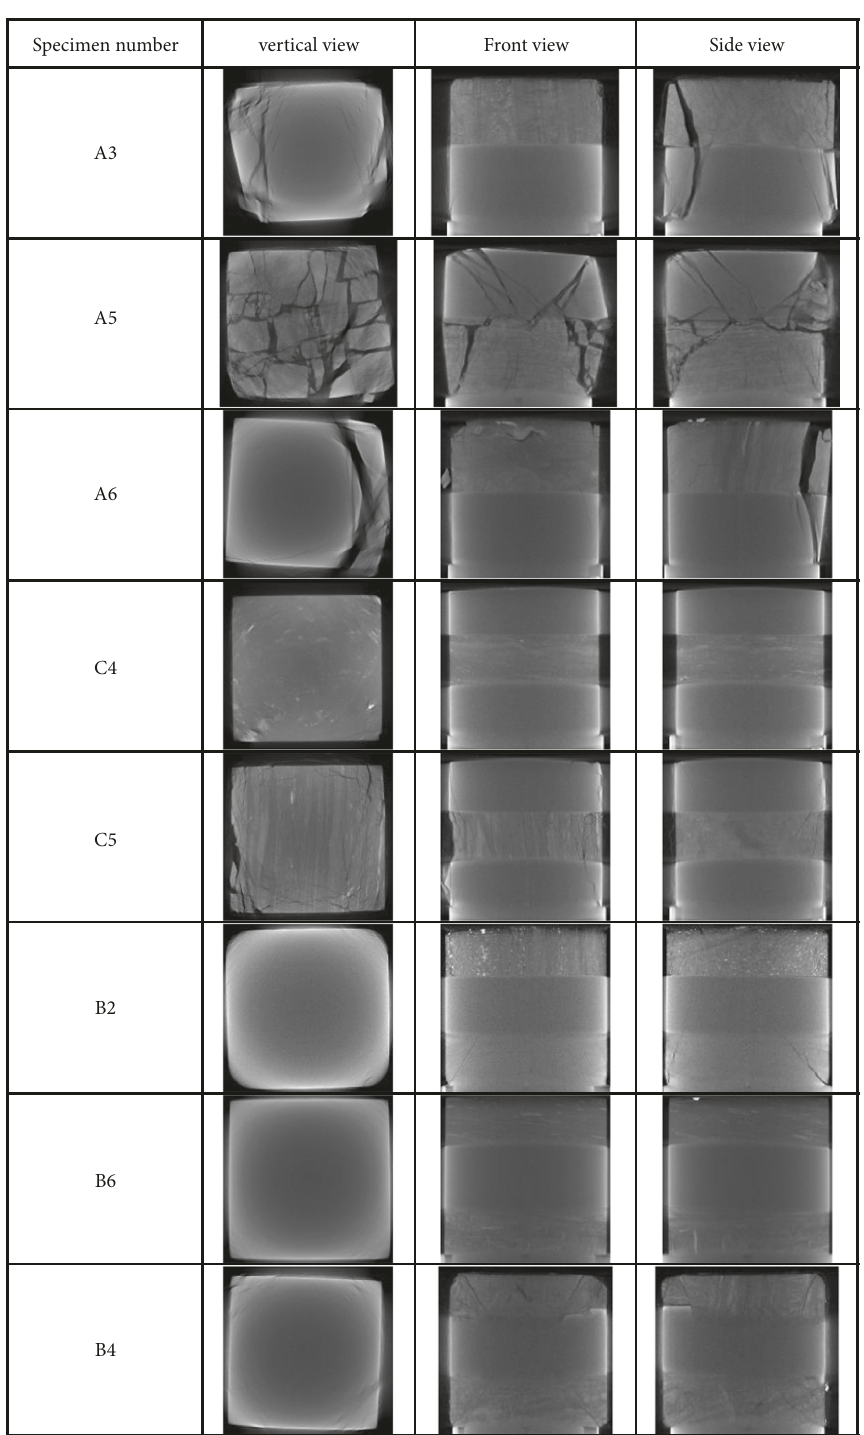
Figure 4: Micro-CT scanning results of coal-rock interbedding specimen after loading and